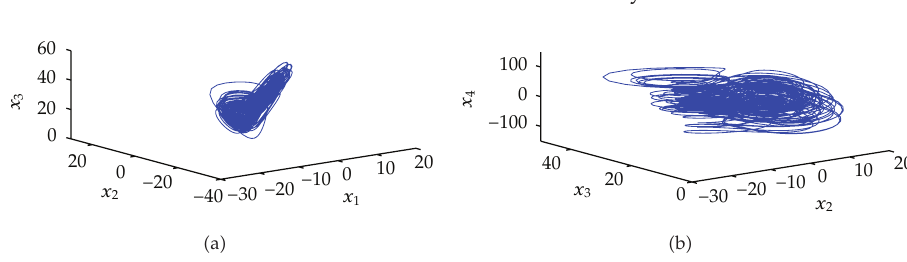
Figure 3: Chaotic attractor of fractional-order hyperchaotic Lu system (cid:4) 3.6 (cid:5) for q (cid:7) 0 .